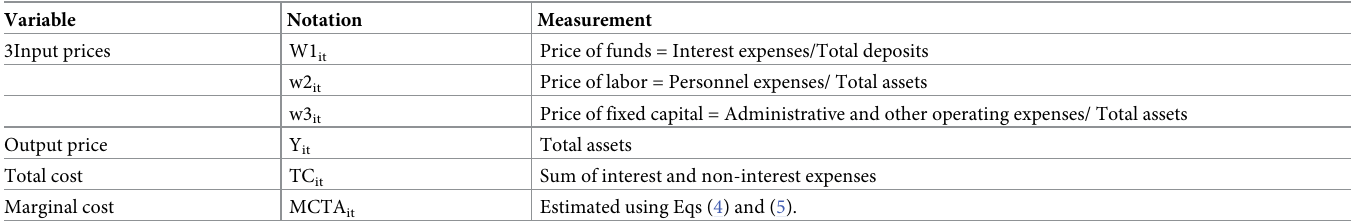
Table 2. Variables used for estimation of the Lerner